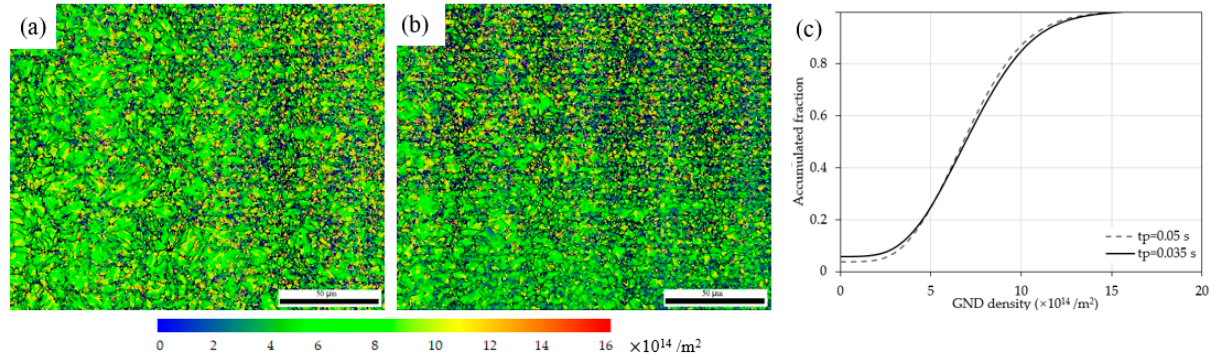
Figure 15. GND mapping of ( a ) t p = 0.05 s, ( b ) t p = 0.035 s and ( c ) accumulated fraction of ( a , b ).